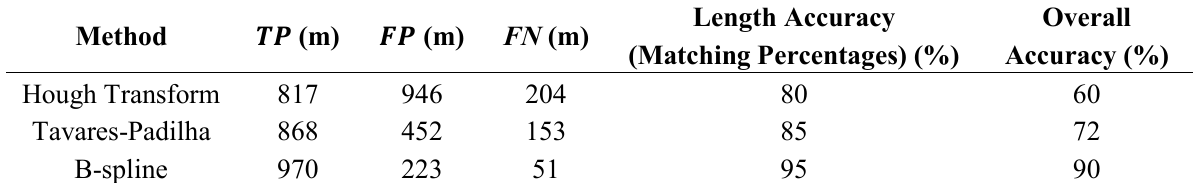
Table 1. Quantitative measures obtained by Hough transform, Tavares-Padilha algorithm and B-spline method for synthetic dataset. True positive (TP) is the number of correctly extracted discontinuities. False positive (FP) is the number of line segments erroneously classified as discontinuities. False negative (FN) is the amount of line segments that were not classified as